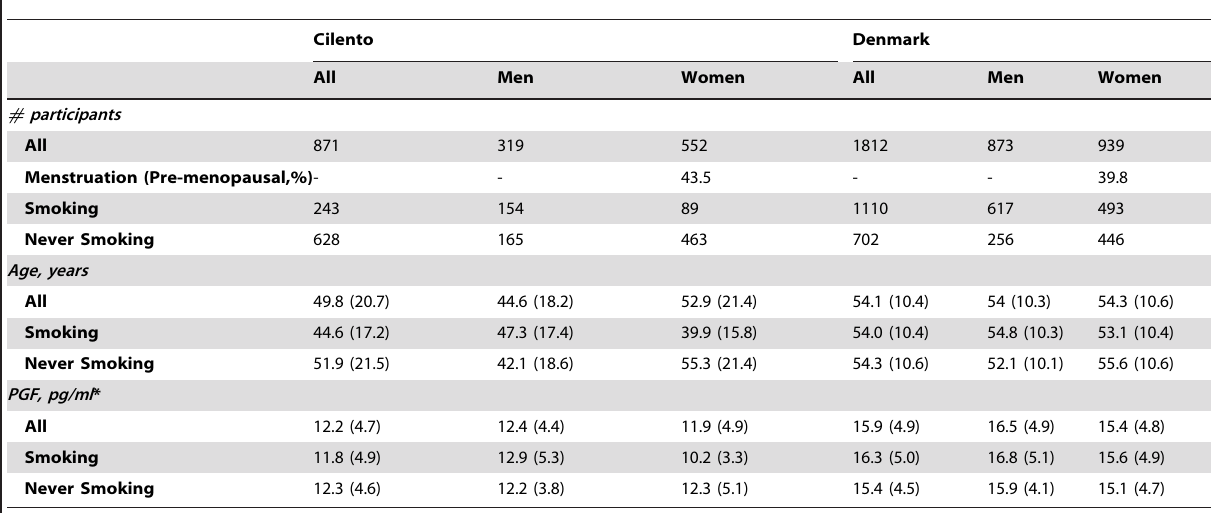
Table 1. The baseline characteristics of the